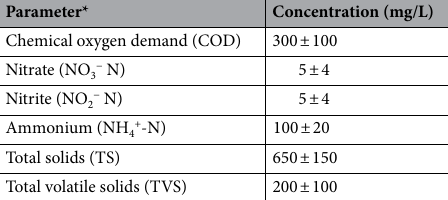
Table 2. Physicochemical characteristics of packed systems influent. *The parameters were quantified according to the techniques described in the analytical methods section.